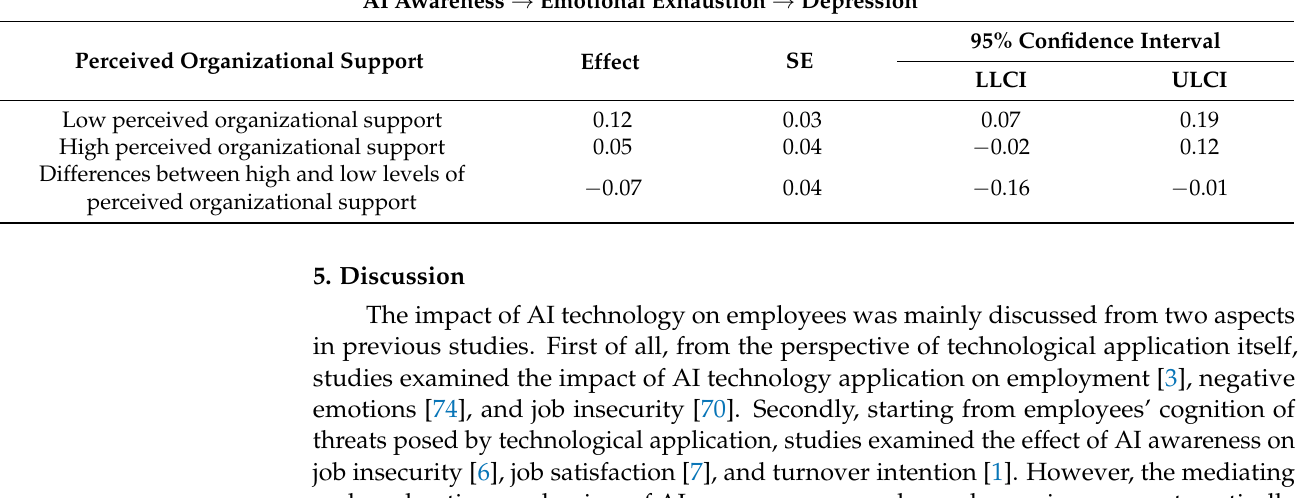
Figure 2. The moderating effect of perceived organizational support.